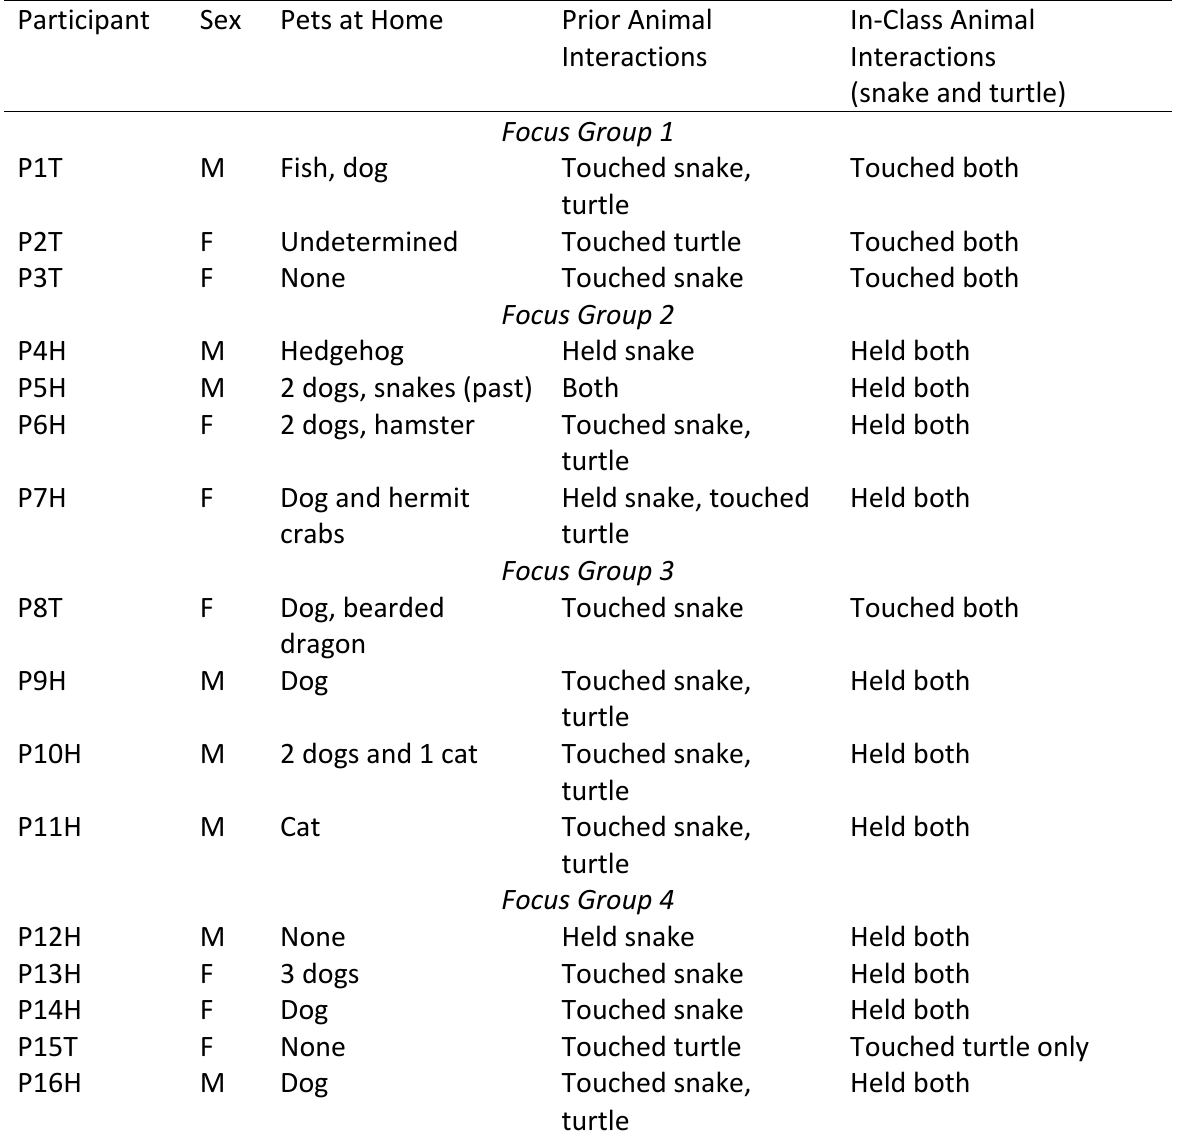
Sample Demographics and Level of Animal Interaction (Two-finger Touch or Hold)